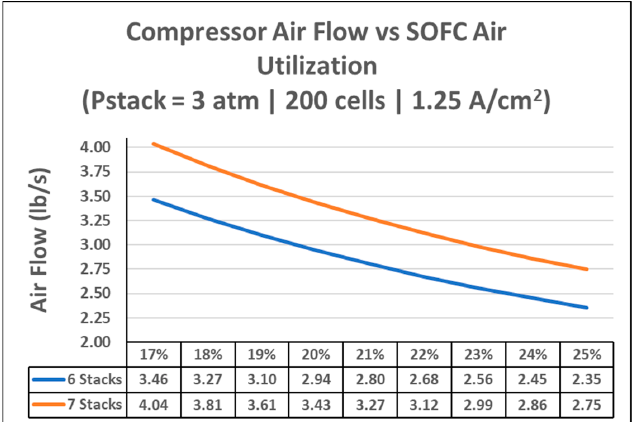
Figure 9. Scenario example for cathode air flow needed to maintain 1.25 A/cm 2 from 17% to 25% air utilization.